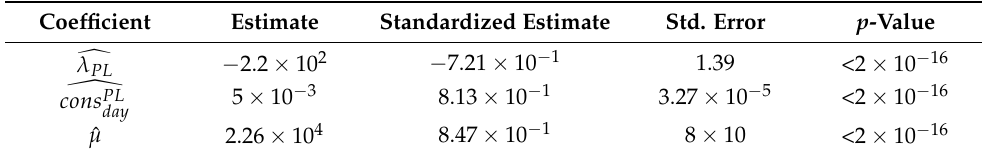
Table 8. Regression analysis coefficients result for pork products containing liver.